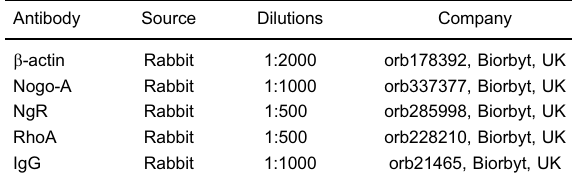
Table 1. Antibodies used in this study.